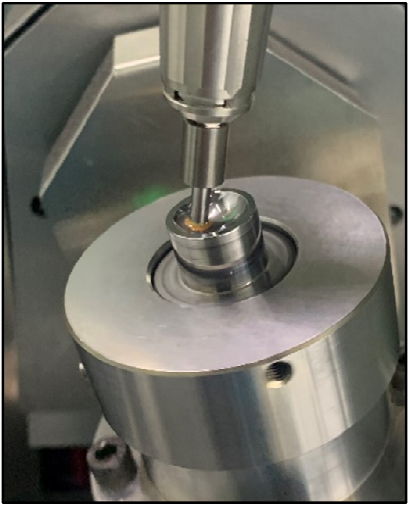
Figure 11. Uniform polishing experiment of disc polishing tool.